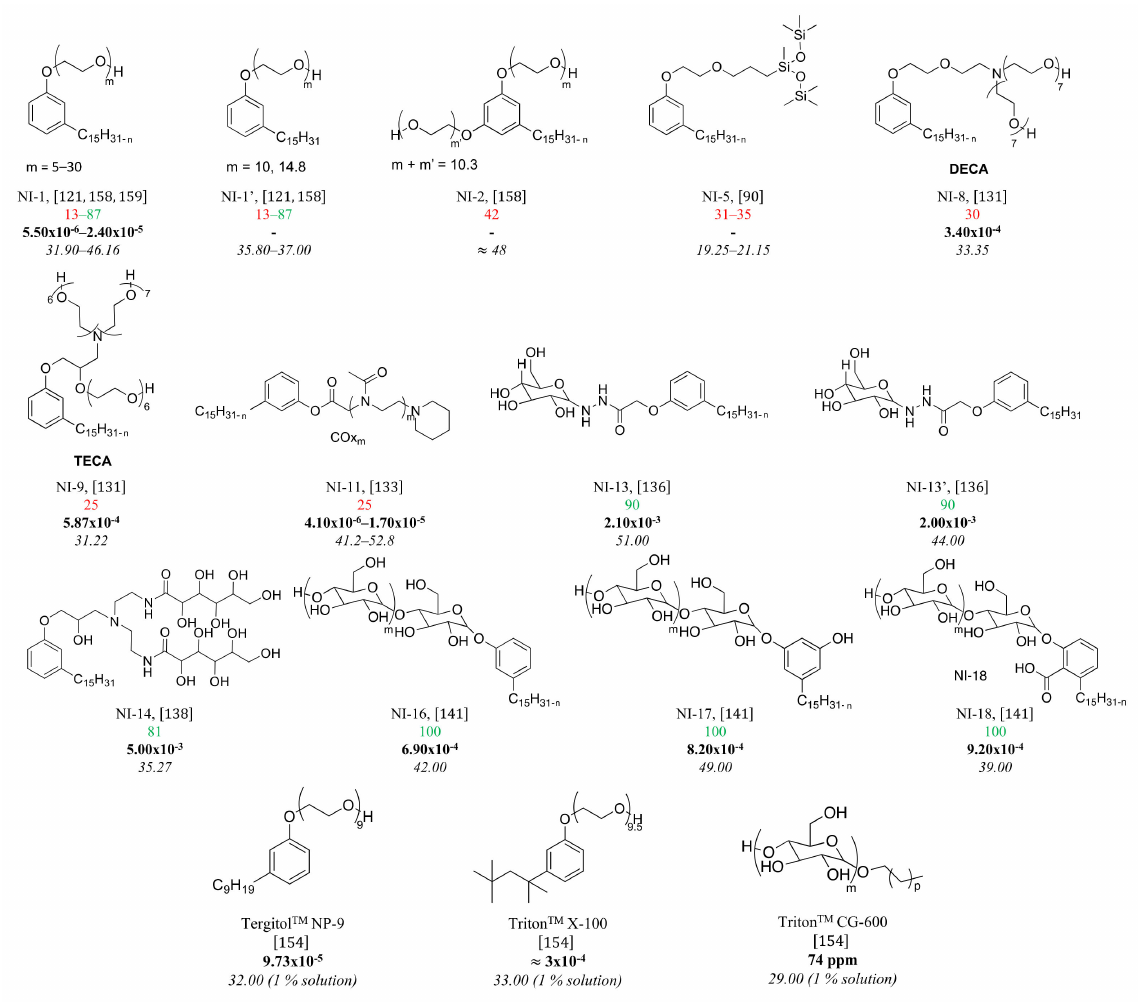
Figure 13. % bio (green for % up to 75%, red for % under 50%), CMC (mol/L, bold) and surface tension (mN/m, italics) of nonionic CNSL-based